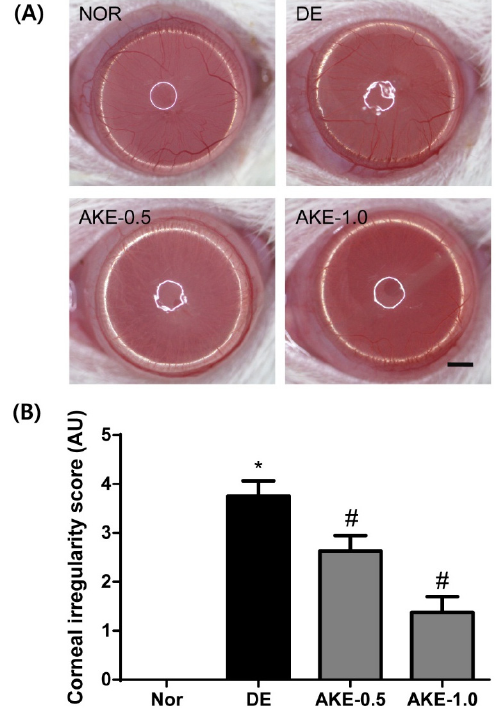
Figure 4. Effects of AKE on corneal irregularity in dry eye mice. ( A ) Reflected images of a white ring